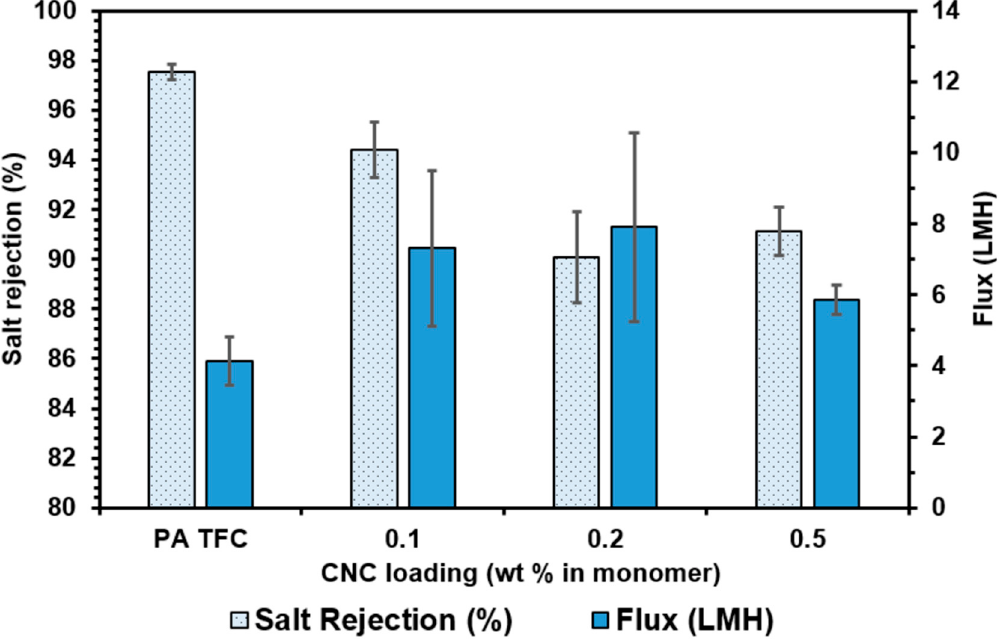
Figure 12. Flux and salt rejection results for CNC containing TFN membranes fabricated using the monomer dispersion method.